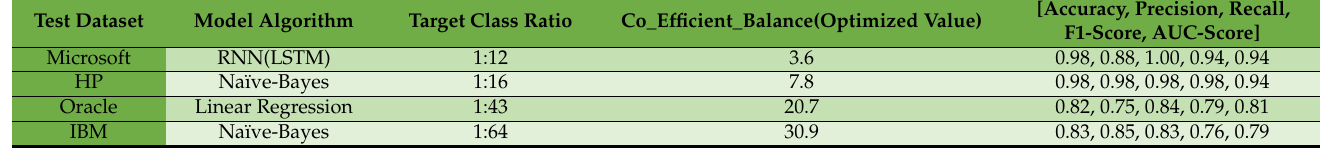
Table 8. Model performance for test